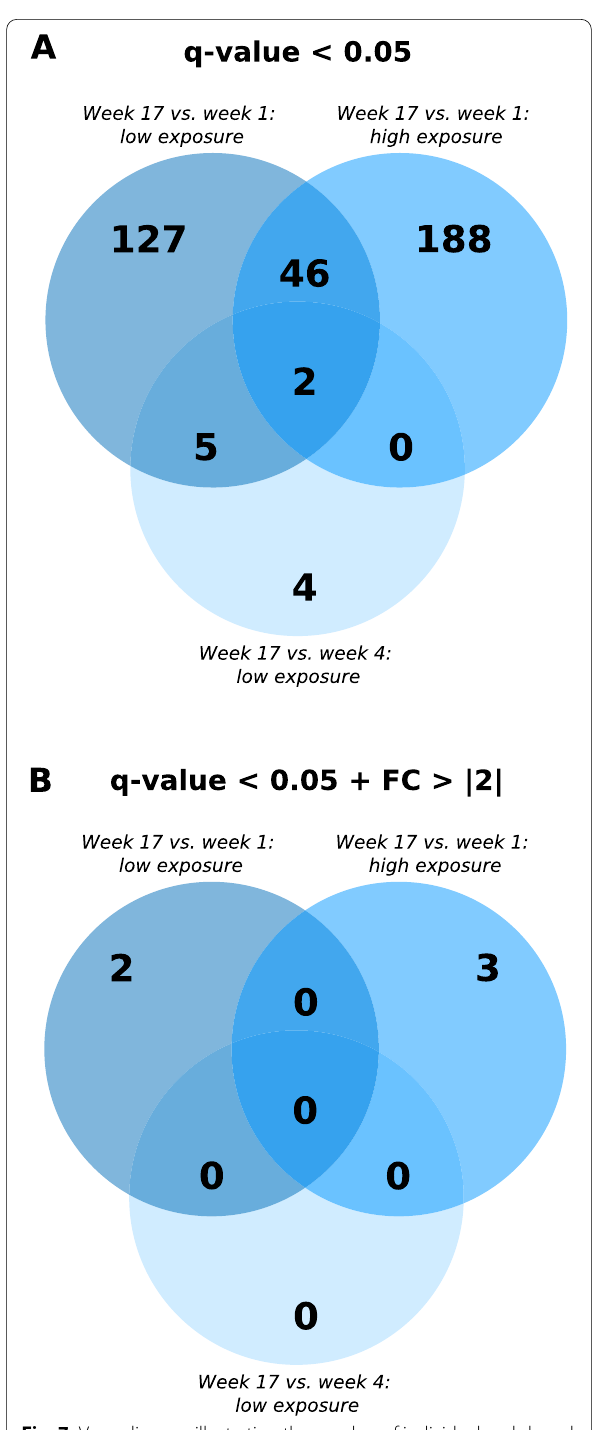
Fig. 7 Venn diagram illustrating the number of individual and shared significantly different protein concentrations for three selected contrasts. (A) Number of proteins with a q -value < 0.05. (B) Number of proteins with a q-value < 0.05 and a fold change (FC) >